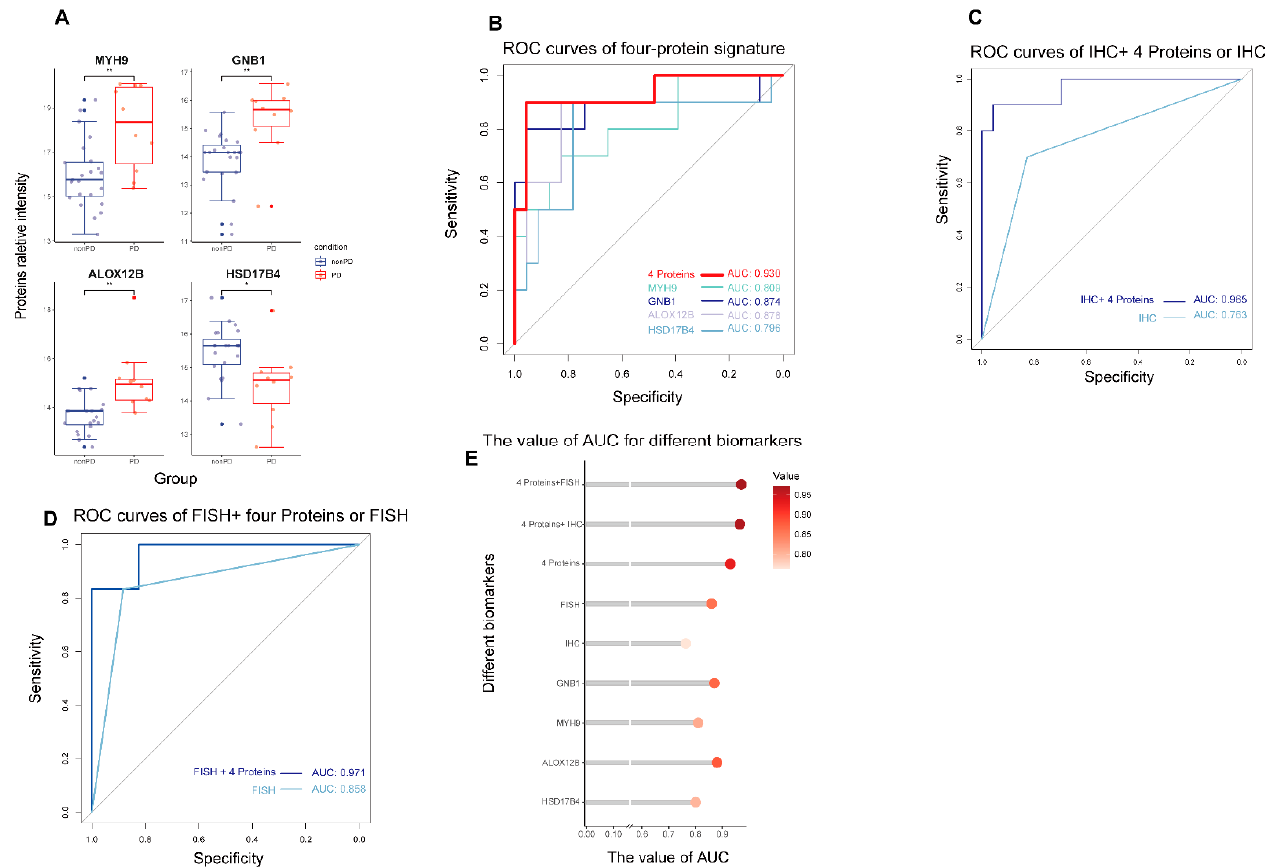
Figure 3. The predictive performance of different models for response to MET inhibitor. ( A ) Box- plots of the relative intensity of four selective protein biomarkers between PD and non-PD groups. * p value < 0.05, ** p value < 0.01. ( B ) The ROC curves for the performance of four proteins, ( C ) IHC, IHC plus four proteins, ( D ) FISH, and FISH plus four proteins in the prediction of response to MET inhibitors for MET-dysregulated lung cancer patients. ( E ) The AUC values of different models.